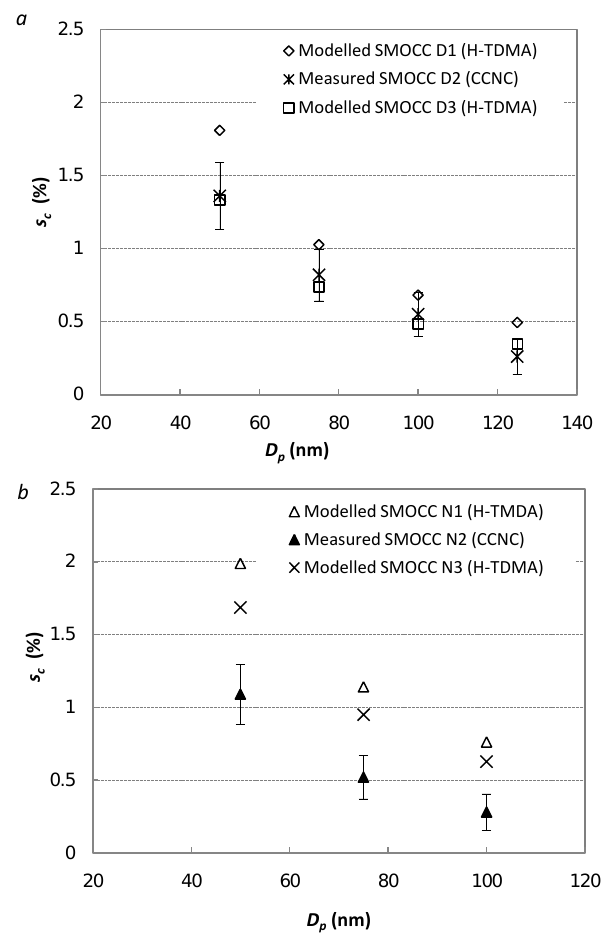
Fig. 9. Illustrating the effect on predicted supersaturation at low growth factors at 90% using the approximated K¨ohler theory at ac- tivation. The κ R model leads to an overestimation of the critical supersaturation. The difference decreases as the dry particle size or GF